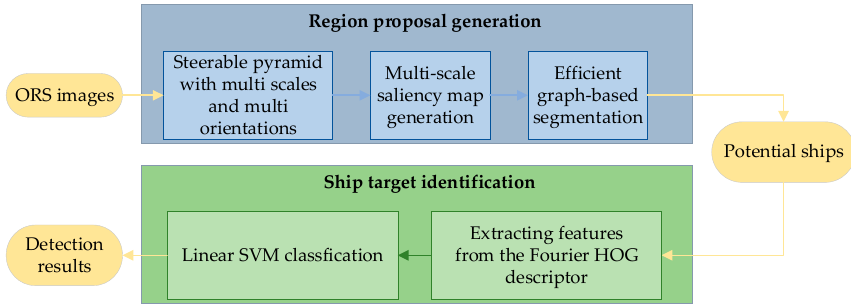
Figure 2. Flow chart of the proposed multi-stage detection scheme. The region proposal stage contains the saliency map generation and the graph-based segmentation. The ship identification stage consists of rotation-invariant feature extraction and the candidate classification. ORS: optical remote sensing; SVM: support vector machine; HOG: histogram of oriented gradients.